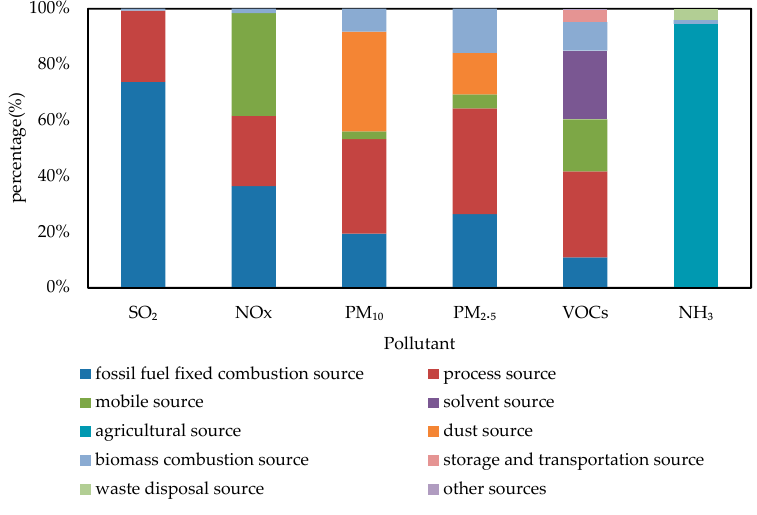
Figure 2. The emission contributions of ten source categories in the Changzhutan urban agglomeration.